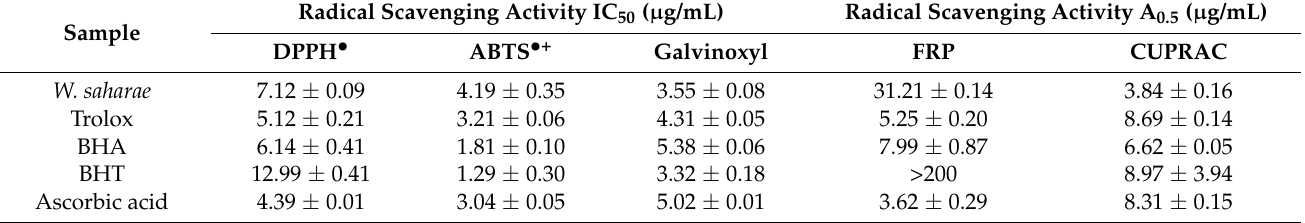
Table 3. Antioxidant activity of the hydromethanolic extract of W. saharae by DPPH • , ABTS • + , galvinoxyl • , FRP, and CUPRAC